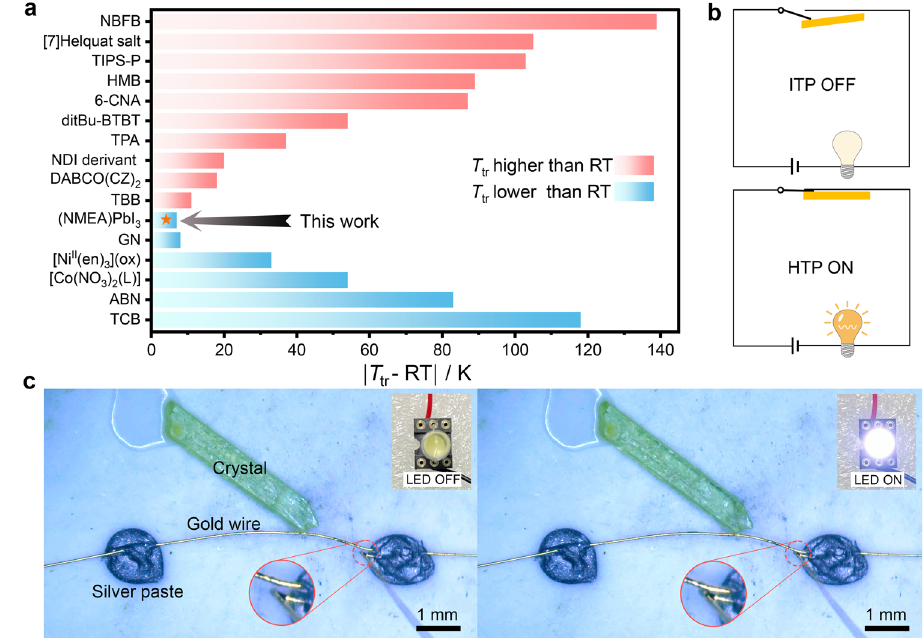
Fig. 6 | Comparison of working temperatures of reported systems and actua- tion device of 1. a Response temperature deviating from room temperature of reportedthermosalientmolecularcrystals.NBFB 39 ,[7]Helquatsalt 47 ,TIP-P 19 ,HMB 48 , 6-CAN 49 , ditBu-BTBT 19 , TPA 17 , NDI derivant 50 , DABCO(CZ) 2 51 , TBB 52 , GN 53 , [Ni II (en) 3 ] (ox) 54 , [Co(NO 3 ) 2 (L)] 55 , ABN 40 , TCB 18 . T tr and RT represent phase